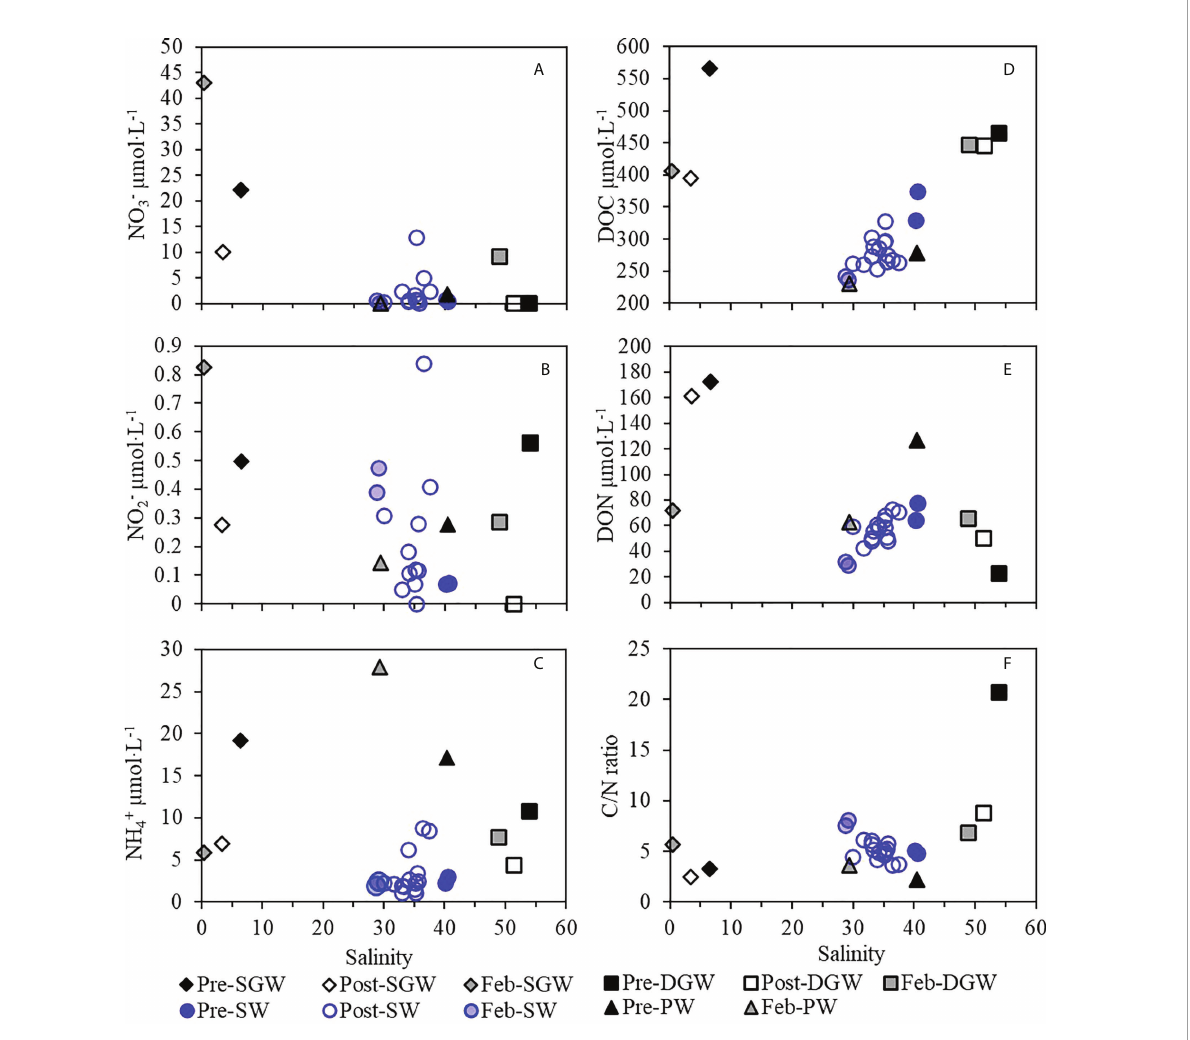
FIGURE 4 Groundwater, surface water, and porewater (A) NO 3 − , (B) NO 2 − , (C) NH 4+ , (D) DOC, (E) DON, and (F) C/N ratio are plotted with salinity as indicators of change in different source water input due to hydrological change. Pre, pre-Harvey; Post, post-Harvey; PW, porewater; SW, surface water; SGW, shallow groundwater; DGW, deep groundwater; DOC, dissolved organic carbon; DON, dissolved organic